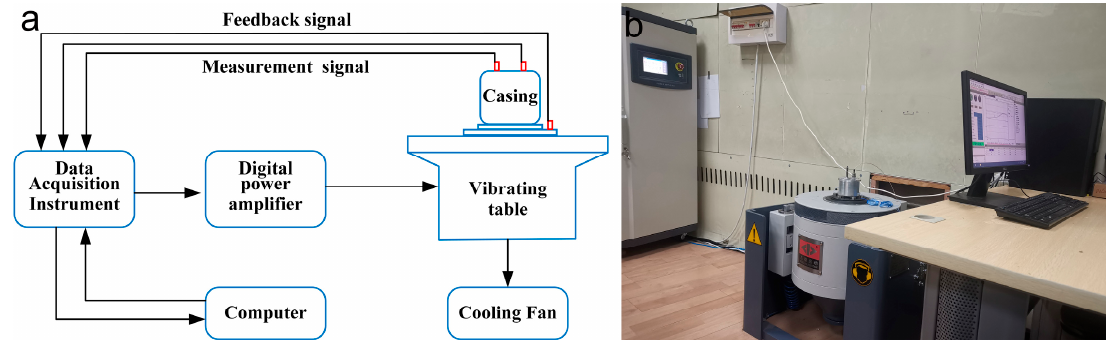
Figure 2. ( a ) Schematic diagram of the experimental equipment system; ( b ) photo of the vibration system. The system structure is presented in Figure 3a. The system structure was mainly com- posed of a vibration table, casing, a rubber isolator, a mass, and accelerometers. Figure 3b shows the installation method of the rubber isolator and the location diagram of the ac- celeration sensor. A3 is the accelerometer for the control signal, and A1 and A2 are the output accelerometers. In this experiment, the linear bearing and the guide shaft were used to suppress the vibration mode of the isolator in other directions. Meanwhile, two